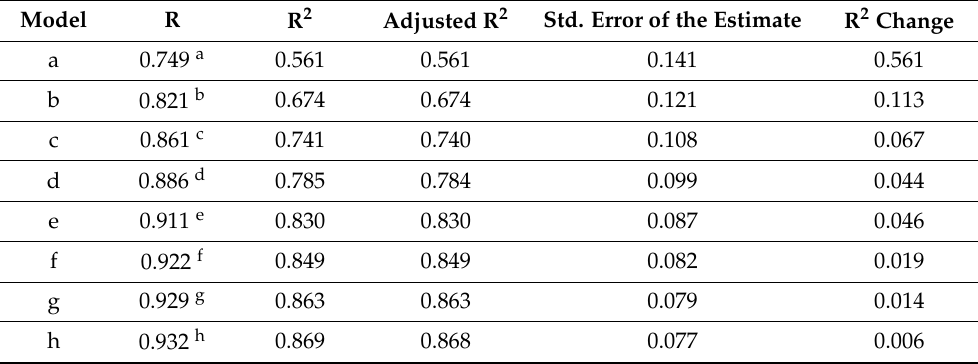
Table 5. Stepwise multivariate linear regression analysis of predictors of epirubicin LnAUC by sequential addition according to best fit. Cumulative R 2 of the final model (h) incorporating all predictors = 0.8690.